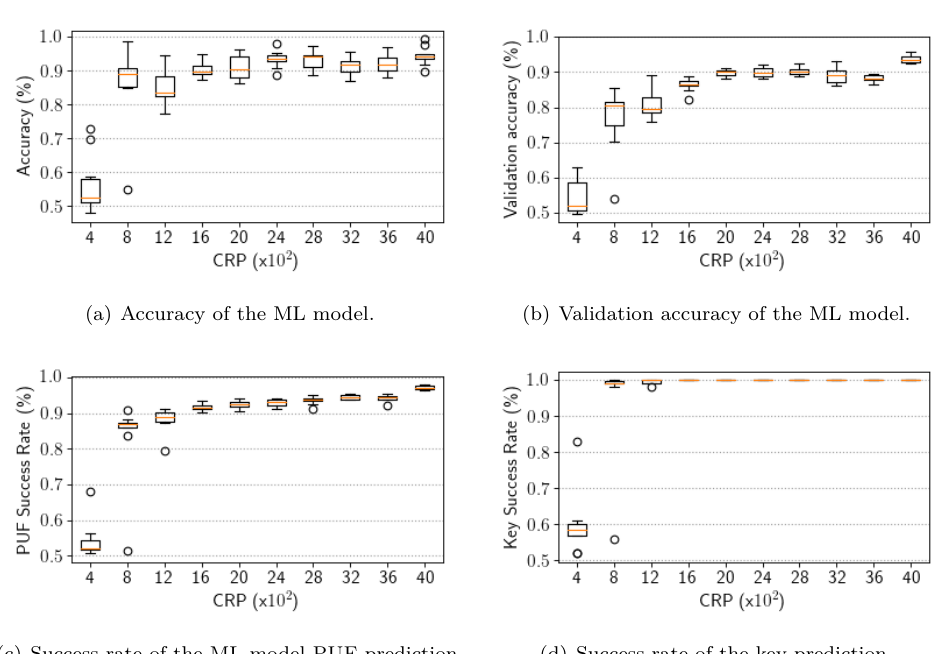
Figure 3: Evaluation of the attack idea using a repetition code with n = 7, 128-SUM PUF and a Siamese neural network. For every number of CRP s ten neural networks were trained and